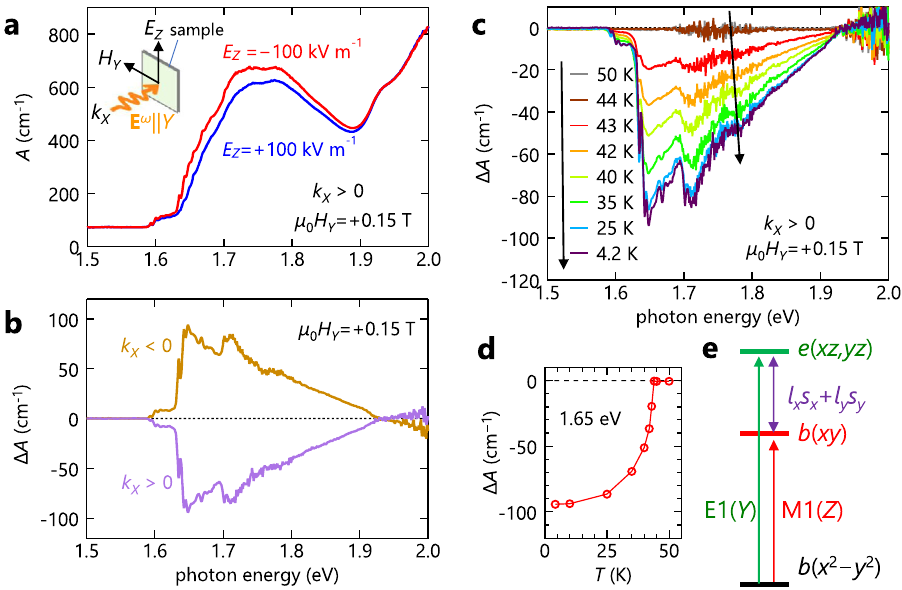
Fig. 2 Evidence for nonreciprocal directional dichroism. a Absorption coef fi cient ( A ) spectra ( k X > 0, E ω || Y ) at 4.2 K. The blue- and the red-colored data were obtained after ME cooling procedure with E Z = + 100 kV m − 1 and − 100 kV m − 1 , respectively, and μ 0 H Y = + 0.15 T. The inset shows an experimental geometry. b Difference absorption spectra, Δ A = A ( + 100 kV/m) − A ( − 100 kV/m), for k X > 0 (purple) and k X < 0 (dark yellow). c Δ A spectra at various temperatures above and below T N = 44 K. d The temperature dependence of Δ A at 1.65 eV, where Δ A takes the maximum in the spectra. In ( a – d ), the cooling electric and magnetic fi elds applied during the ME cooling were removed before each measurement. e Schematic hole-energy spectrum of Cu(3 d )- O(2 p ) bonding molecular orbitals of the square-planar CuO 4 6 − unit partly reproduced from ref. [ 38 ]. a ( z 2 ) is omitted for clarity. An electric-dipole (magnetic-dipole) transition with a Y- ( Z -)axis electric (magnetic) fi eld of light, allowed in C4 symmetry, is denoted by a green (red) arrow. A spin – orbit coupling term l x s x + l y s y hybridizes b ( xy ) and e ( xz ) [ e ( yz